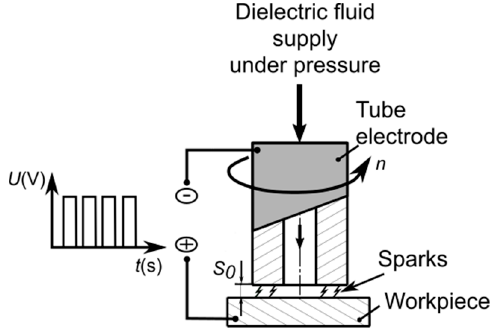
Figure 3. The scheme of the electrical discharge drilling (EDD) process.